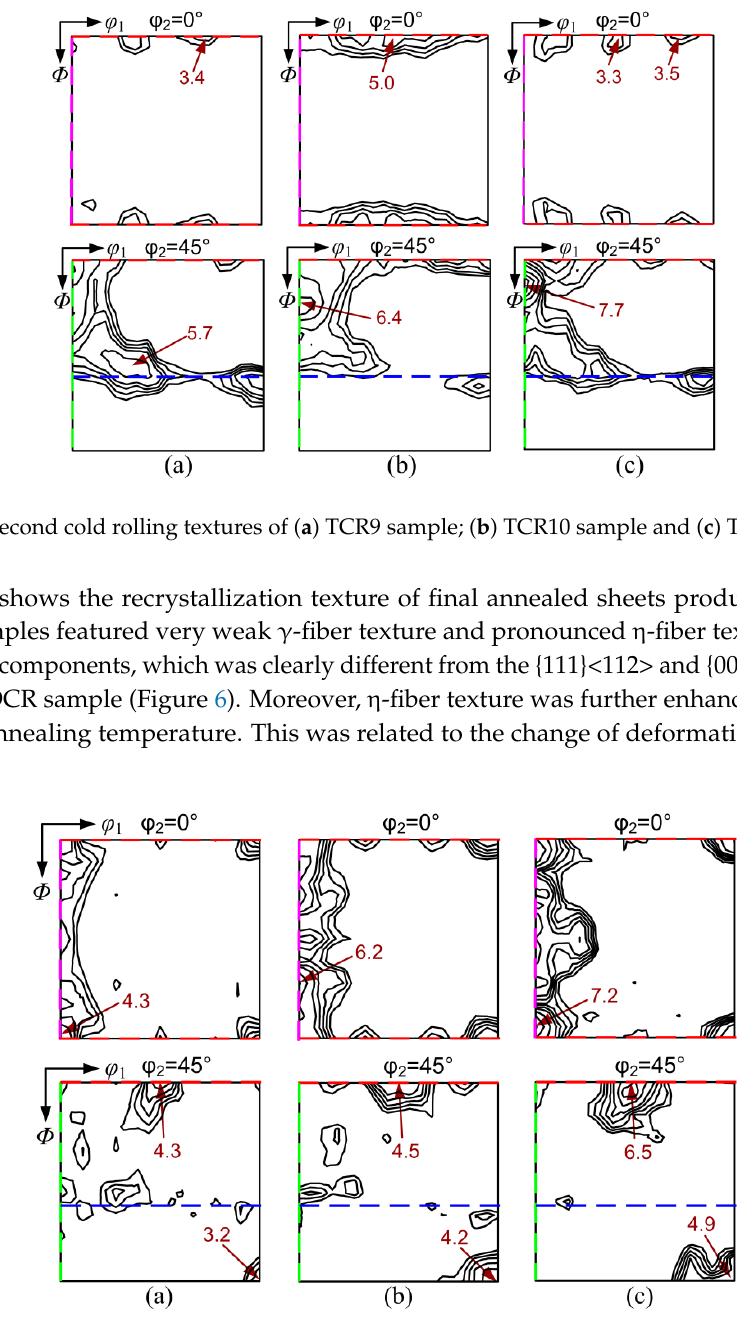
Figure 10. Final annealing textures of ( a ) TCR9 sample; ( b ) TCR10 sample and ( c ) TCR11 sample.